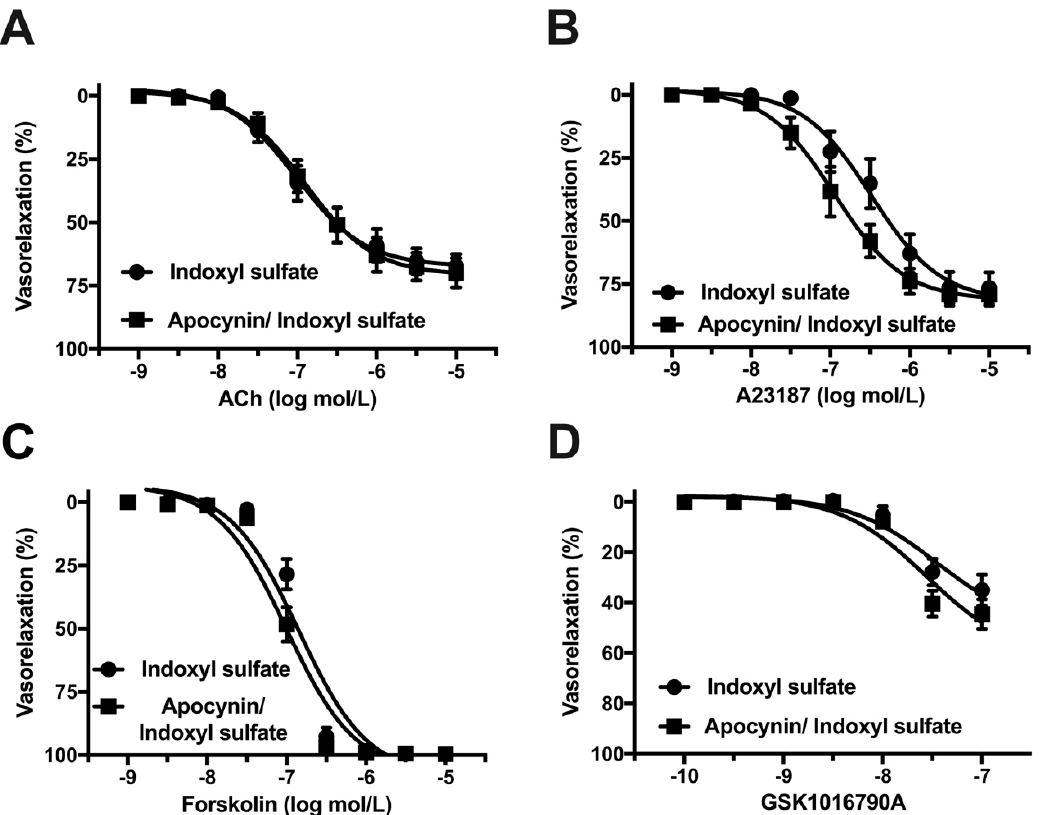
Figure 8. Effect of an NADPH oxidase inhibitor on vasorelaxations induced by acetylcholine (ACh) ( A ), A23187 ( B ), forskolin ( C ), or GSK1016790A ( D ) in the aorta treated with indoxyl sulfate. Apocynin (10 − 4 mol/L) or vehicle (DMSO) was applied for 30 min; thereafter, indoxyl sulfate (10 − 4 mol/L) was incubated for 30 min before phenylephrine (PE) application. The ordinate shows vasorelaxation as a percentage of the PE-induced vasocontraction (0% being defined as the plateau level of precontraction). Data are presented as mean ± standard error of mean (SEM) values from eleven ( A ), ten ( B ), and twelve ( C , D ) experiments.